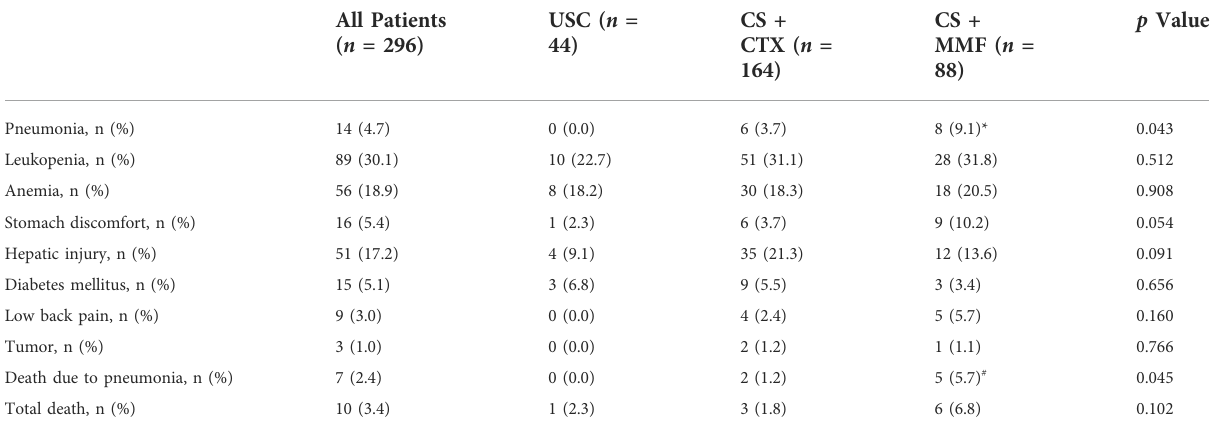
TABLE 3 Adverse events in IgA nephropathy patients with moderate renal insuf fi ciency.